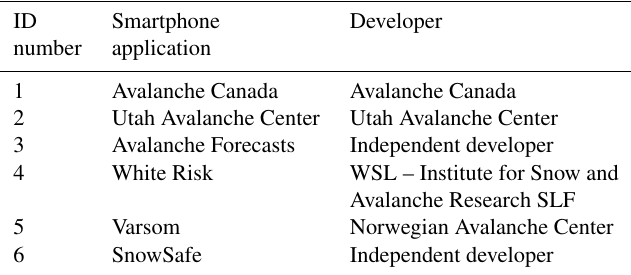
Table 1. Smartphone applications